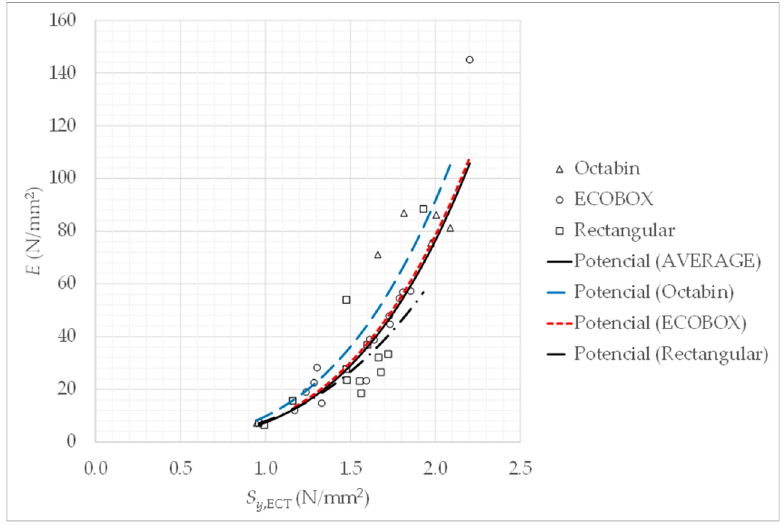
Figure 8. Relationship between deformation modulus and stress for the corrugated cardboard boxes.